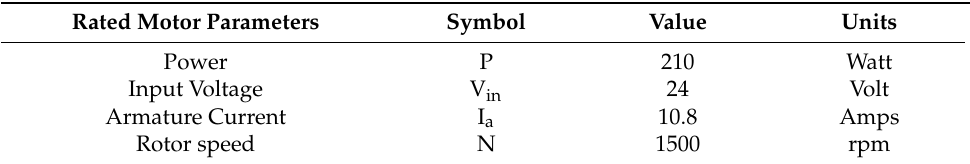
Figure 12. Transient behavior with PI controller (experimental). ( a ) Delay Time, ( b ) Rise Time, ( c ) Peak Time, ( d ) Settle